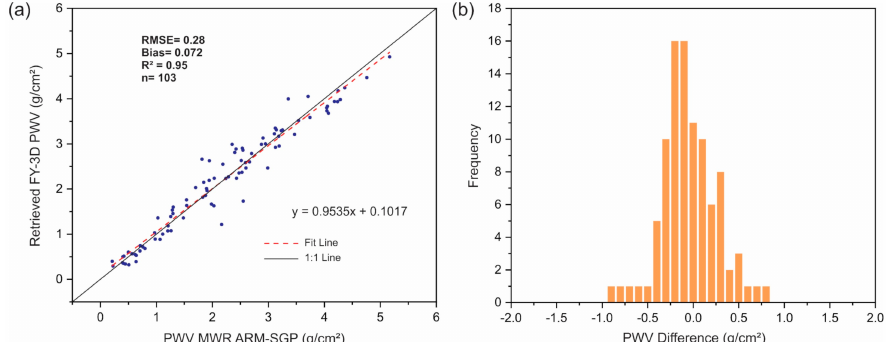
Figure 6. The scatterplot ( a ) depicts the retrieved PWV values from the proposed algorithm versus ground-based microwave radiometer measurements where the black line is the ratio of 1:1; the red dotted line is the line fitted based on all the matched points and ( b ) the frequency distribution of the di ff erence between the retrieved PWV and ground-based measurements.